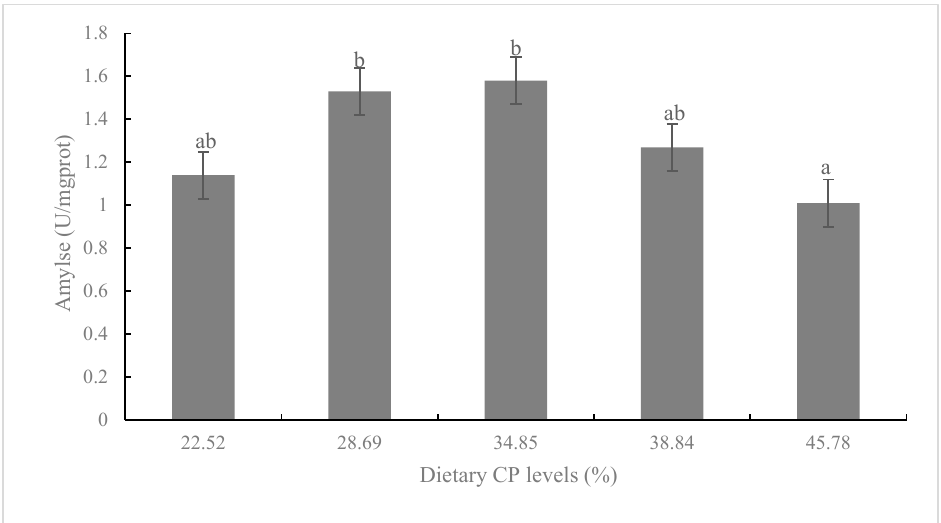
Figure 4. Amylase activity of juvenile K. punctatus fed diets containing different CP levels. Value columns with different letters mean significant difference ( p < 0.05).